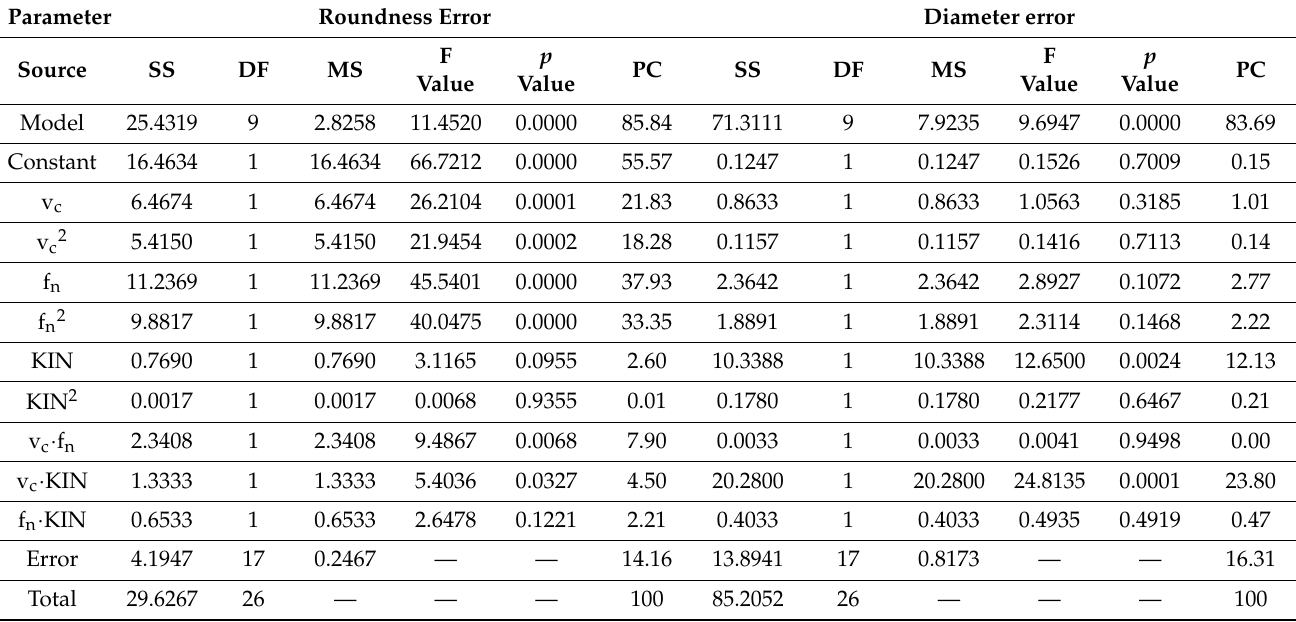
Table 6. ANOVA results including the percentage contribution (PC) of the process parameters and the type of kinematic system for the roundness and diameter